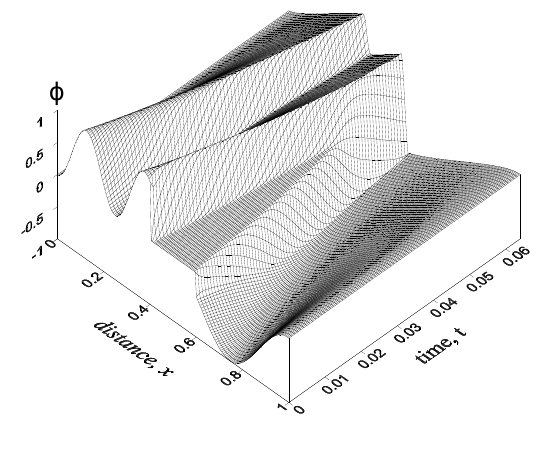
Fig. 2. Field Fig. 2. Field evolution.